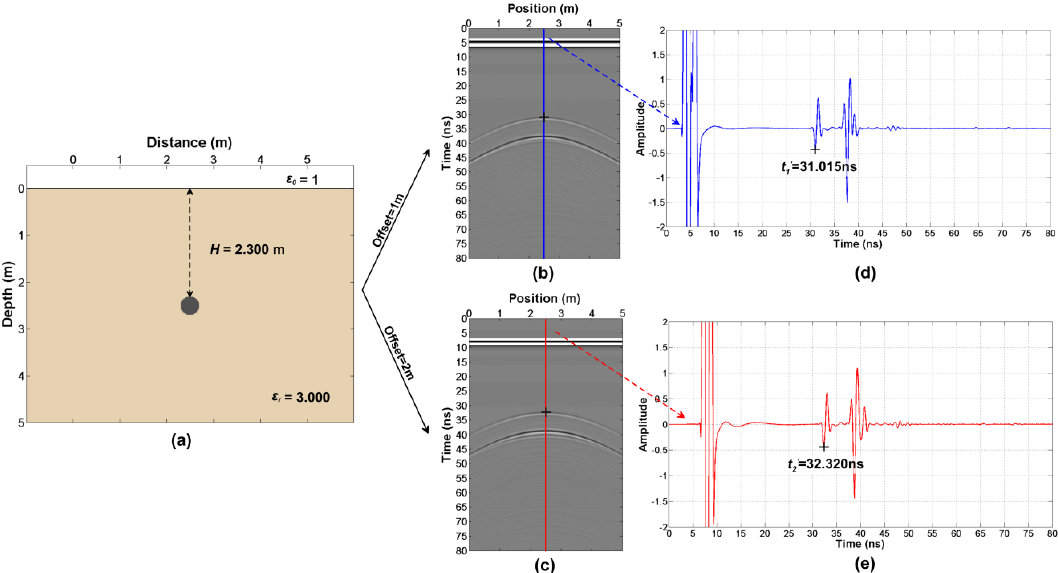
Figure 5. The second case (transmitter and receiver is of 0.5 m high from the ground): ( a ) The model; ( b ) The forward result with an offset of 1 m; ( c ) The forward result with an offset of 2 m and ( d – e ) The single traces as shown in the figure. Sensors 2018 , 18 , x